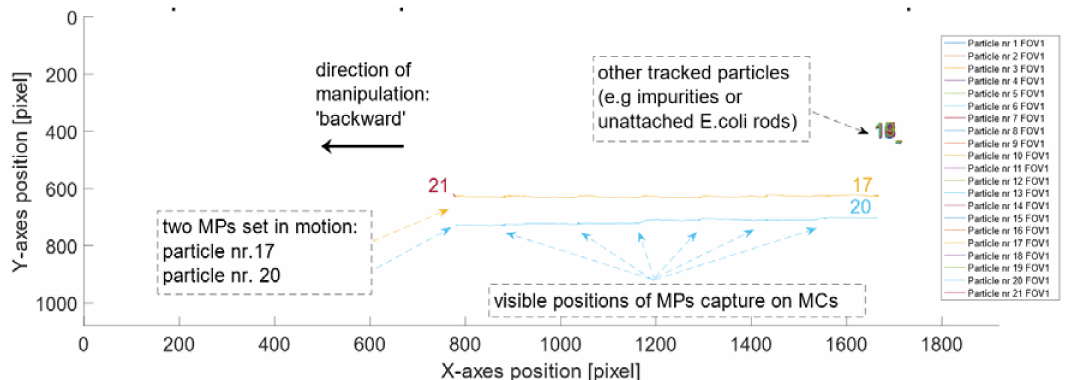
Figure 10. For MLBs with concentration of 2 × 10 3 CFU/mL: Positions for all the detected and tracked MLBs over a sequence of frames (1920 × 1080 pixels) recorded at 25 fps. There are some characteristic points visible on these trajectories. They correspond to the position of the MLBs as they were captured above the MCs. There are over 21 particles (including impurities) detected for this sample. MLB Nr. 17 and MLB Nr. 20 correspond to two different MLBs that were set in motion due to the magnetic field gradient.